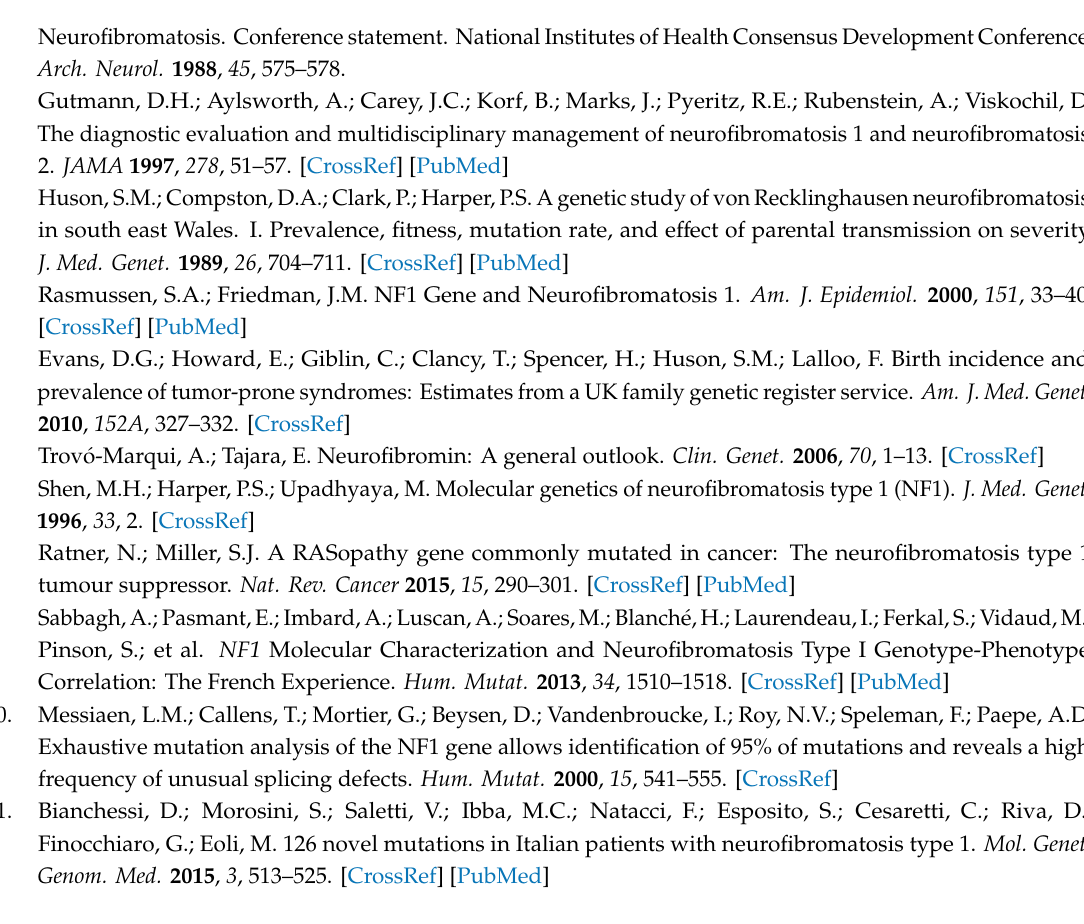
Table S1: Mutations in NF1 gene tertiles and the risk of developing OPG in the combined cohort of our and Anastasaki’s patients; Table S2: Mutations in di ff erent NF1 gene regions and the risk of developing OPG in the combined cohort of our and Anastasaki’s